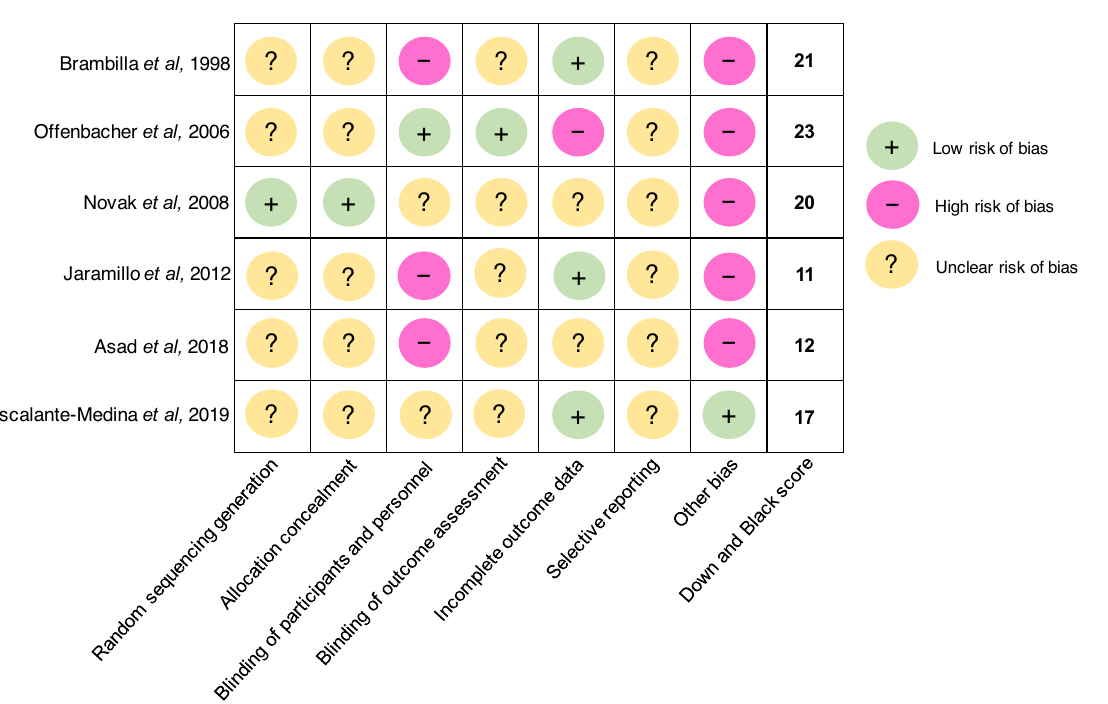
Table 7. Impact of systemic health conditions on oral microorganisms during pregnancy. GA gestational age, SES social economic status, RCT randomized controlled trial, SRP scaling and root planning.